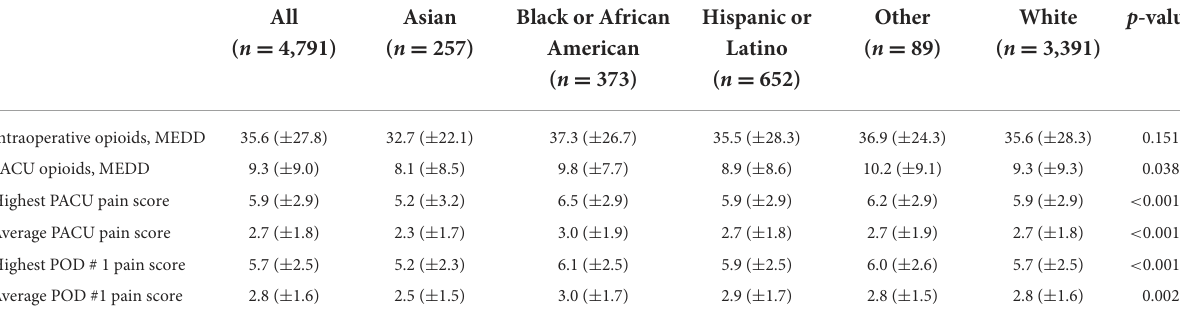
TABLE 3 Opioid administration and average pain scores of 4,791 adults undergoing open abdominal surgery for cancer.